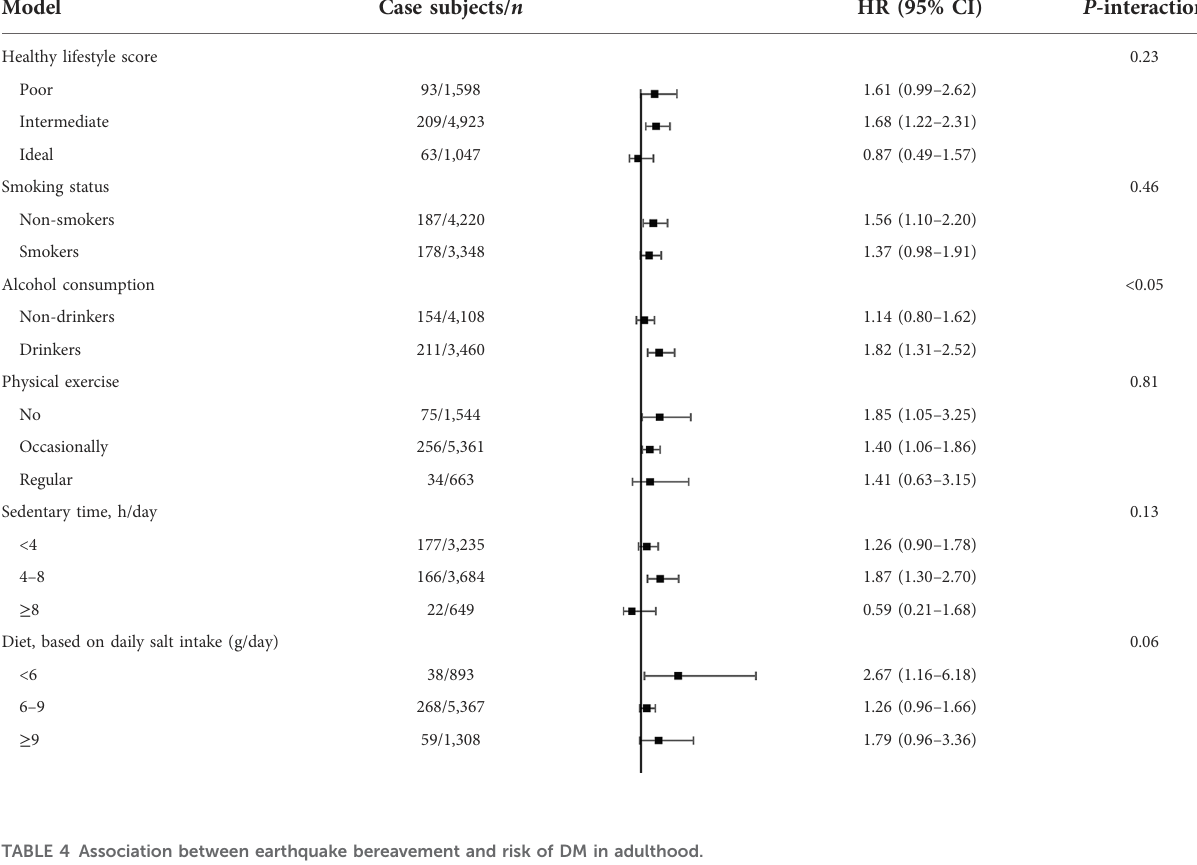
TABLE 3 Multivariable-adjusted HRs (95% CIs) for the association between earthquake exposure in early life and DM according to subgroup analysis among participants. Model